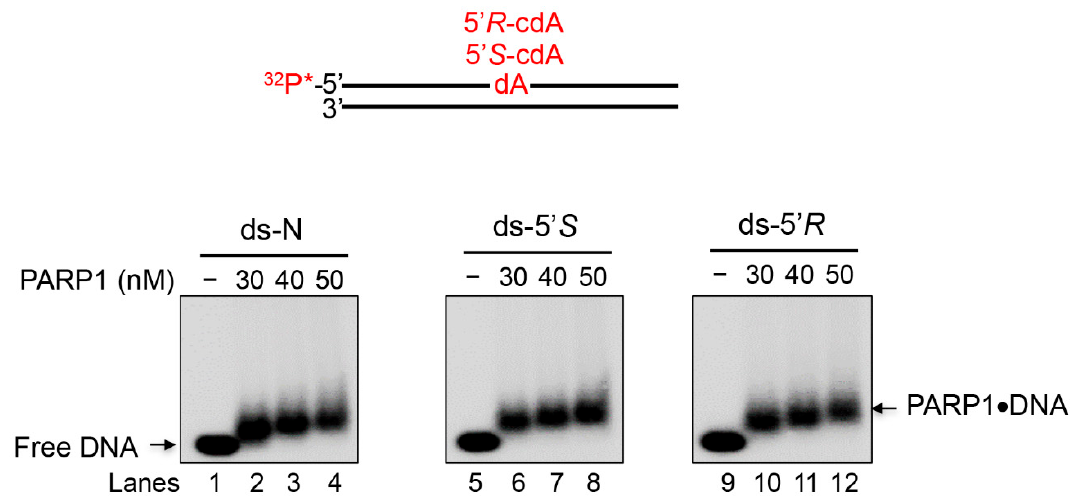
Figure 4. Gel mobility shift assay for determining PARP1 binding to ds-oligonucleotides with cdA lesions. Lanes 1, 5, and 9 correspond to the substrate only. Lanes 2, 6, and 10 correspond to the binding mixture with 30 nM PARP1. Lanes 3, 7, and 11 correspond to the binding mixture with 40 nM PARP1. Lanes 4, 8, and 12 correspond to the binding mixture with 50 nM PARP1. The DNA substrates are schematically illustrated above the gel. Grouping of gels are cropped from different parts of the same gel. The original gel is represented in Figure S6. The gel mobility shift assay procedure is described in the Materials and Methods in the main text. * represents a phosphate group.